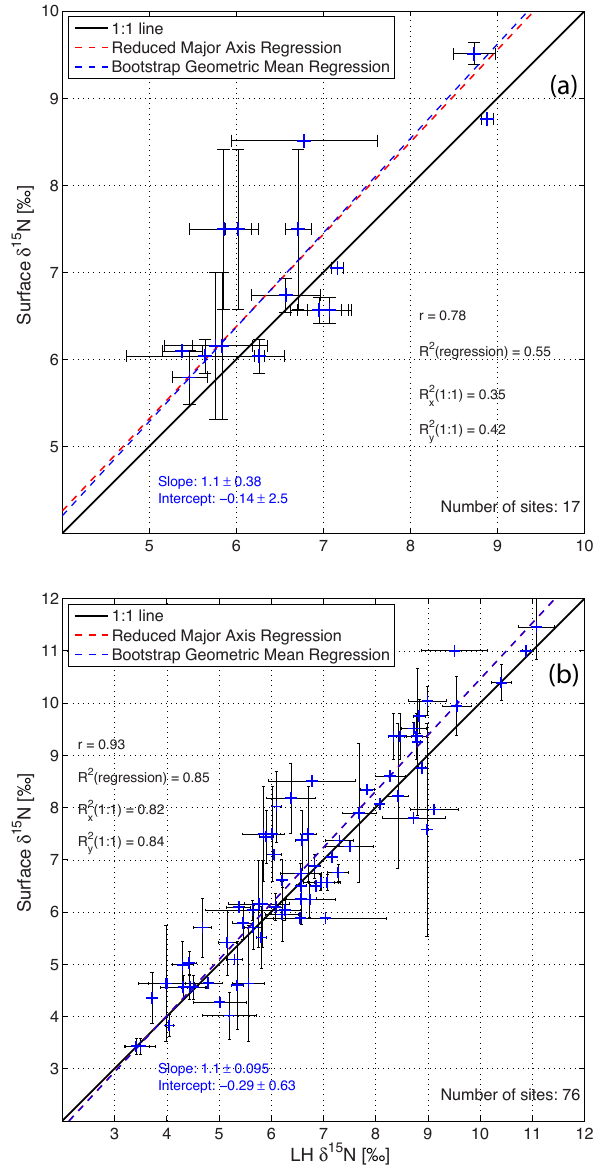
Fig. 6. LH δ 15 N average compared with surface δ 15 N within 100km for (a) the eastern equatorial Pacific and (b) for all available records. The horizontal whiskers show the temporal variance of the LH average, and the vertical whiskers indicate the spatial variance of the surface sample